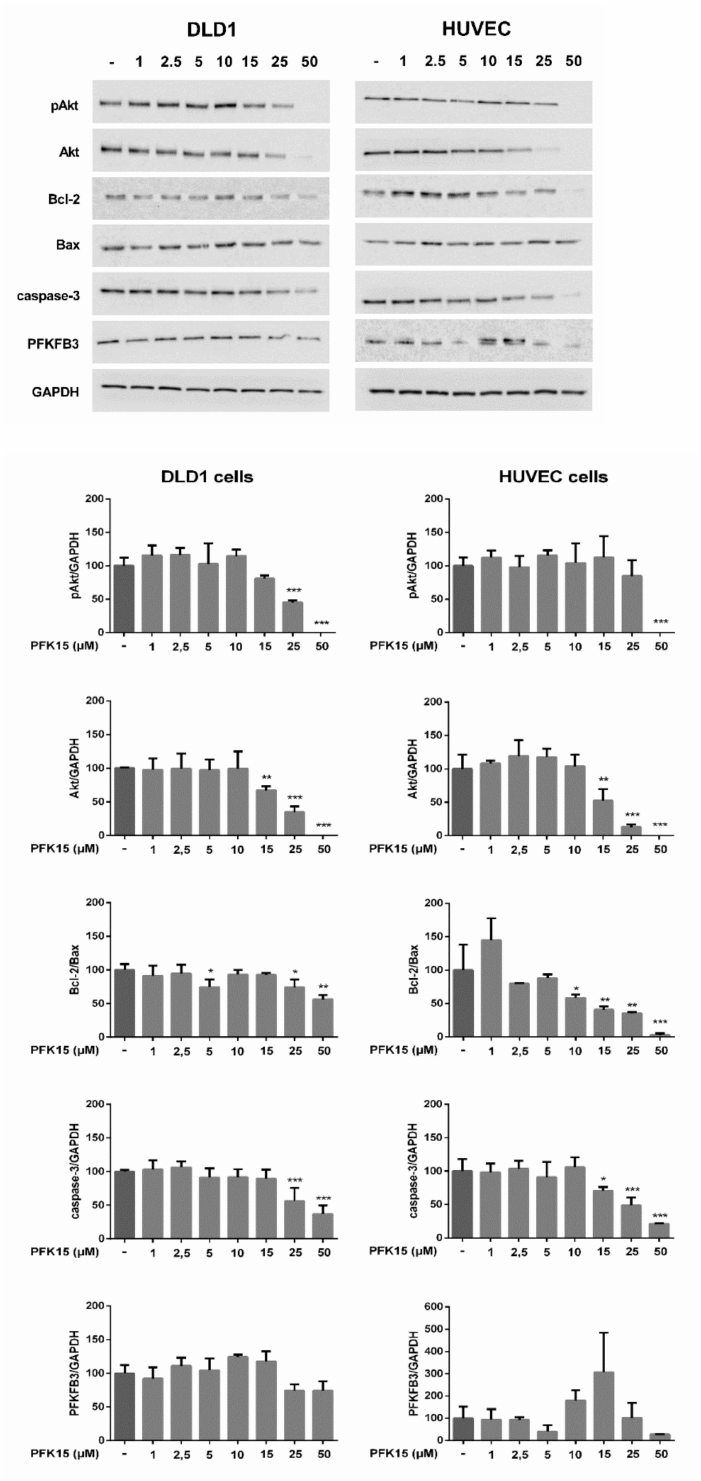
Figure 4. Effect of PFK15 on the level of proteins associated with cell proliferation, apoptosis, and glucose metabolism in DLD1 and HUVEC cells. Cells were treated with PFK15 in a concentration range from 1 to 50 µ M for 24 h. Western blots were quantified by densitometry and expressed as the percentage of protein expression compared to the reference protein GAPDH used as a loading control. Untreated cells incubated only in medium served as the control (100%). Data represent the mean ± SEM of three independent experiments. * p < 0.05, ** p < 0.01, *** p < 0.001 significant difference compared to untreated control